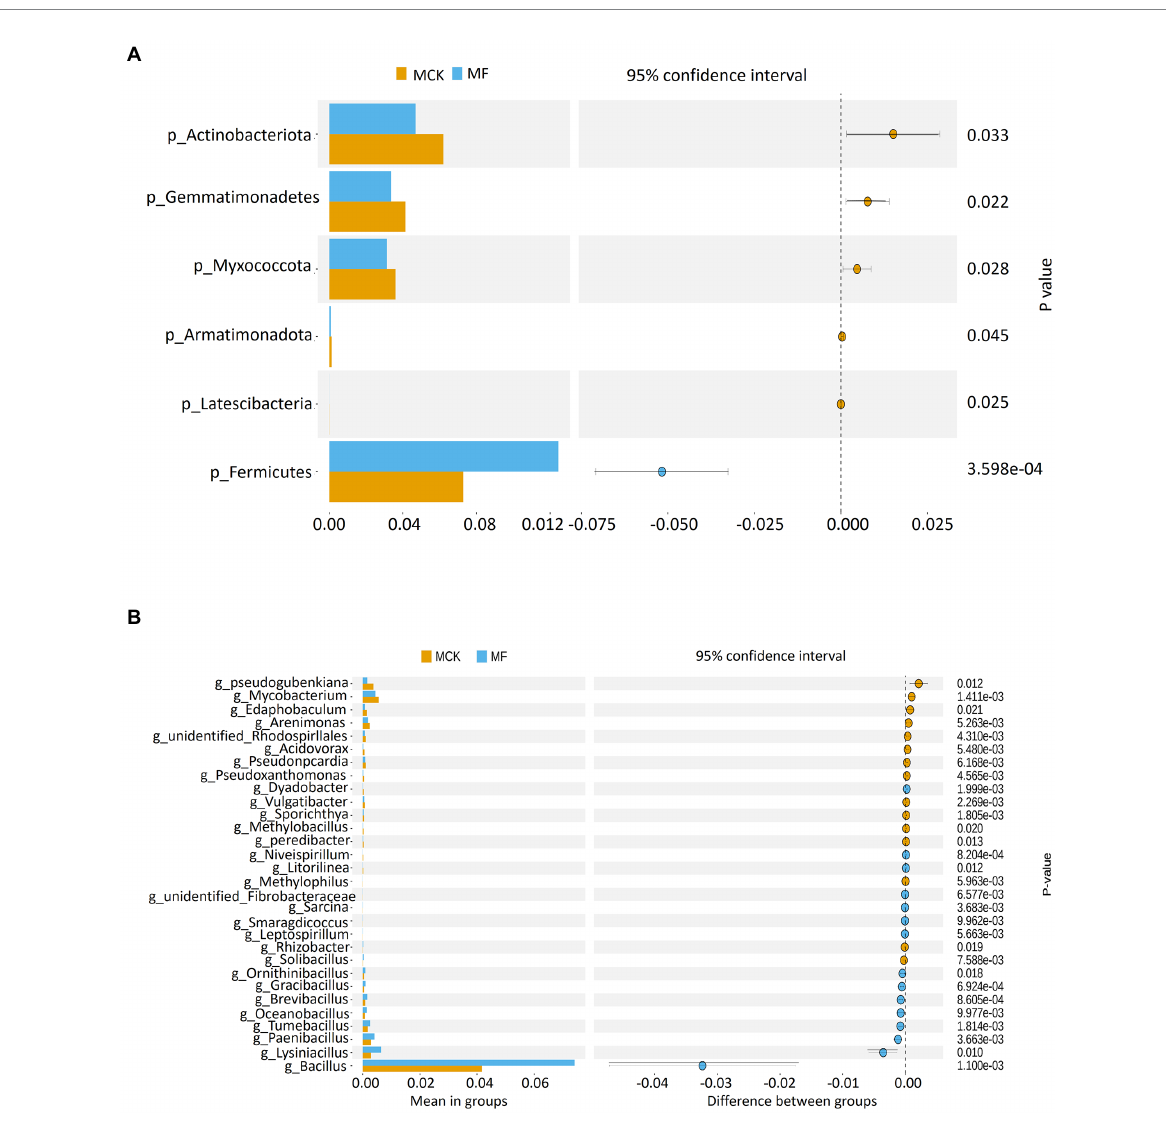
FIGURE 1 T -test showing bacterial groups with significant differences at (A) phylum and (B) genus levels between Cucumis melo var. saccharinus treatment groups MCK and MF at p <